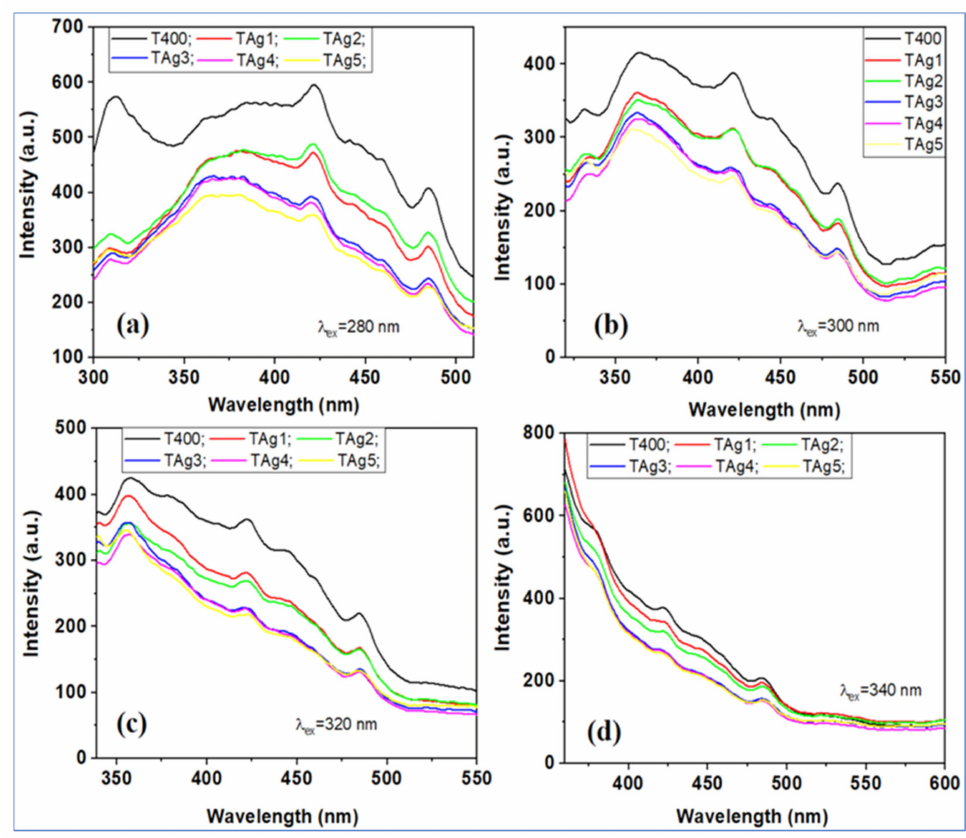
Figure 7. Emission spectra of pure TiO 2 and Ag–TiO 2 nanostructured nanofibers at different excitation wavelengths λ ex = 280 nm ( a ), 300 nm ( b ), 320 nm ( c ) and 340 nm ( d ). Reproduced from Ref.